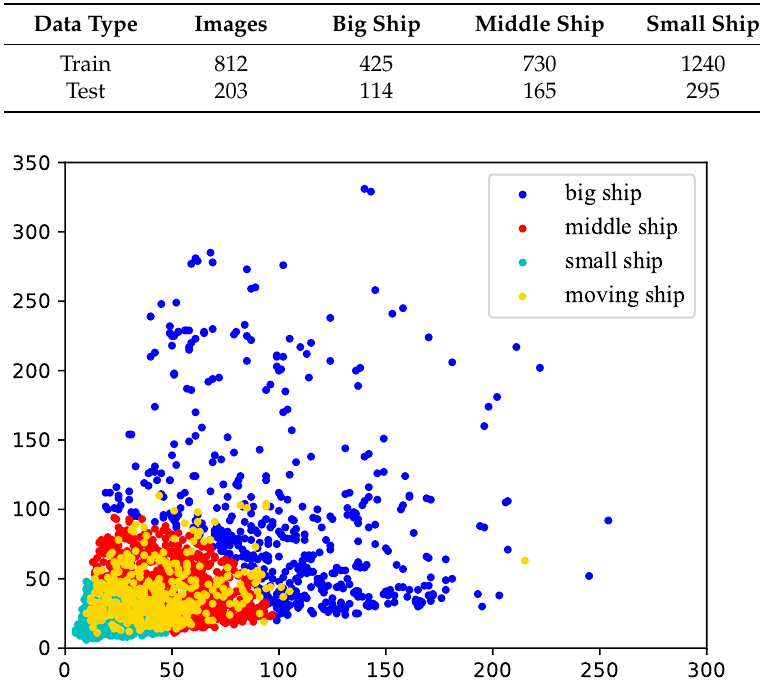
Figure 4. Some example images in our MSD dataset. Table 1. Overview of our MSD.